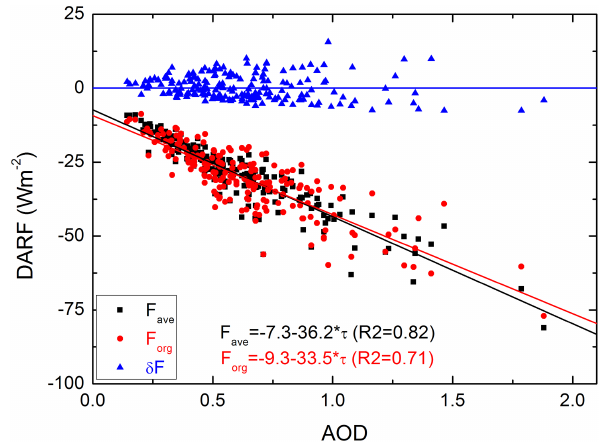
Figure 7. The frequency distributions of τ ave , ω ave , g ave , δF , and 100 · abs